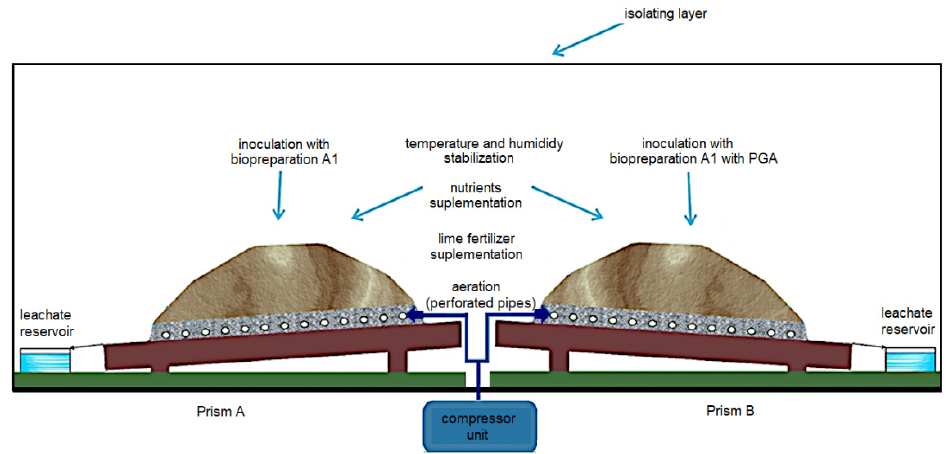
Figure 1. Stand for testing the process of biodegradation of petroleum hydrocarbons.